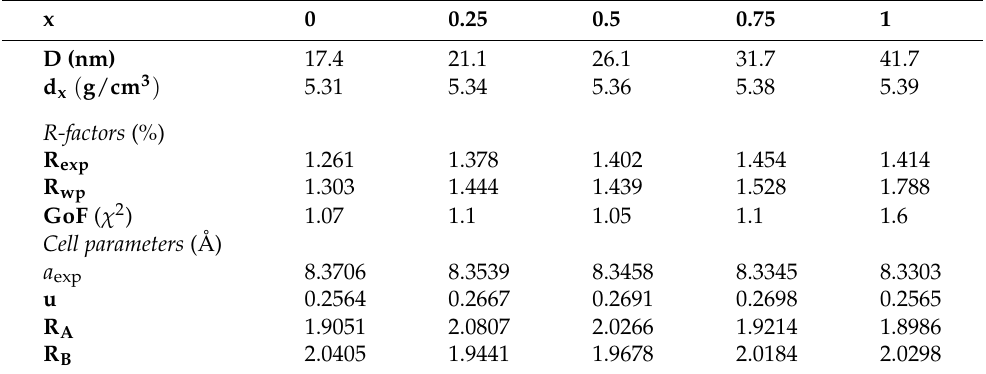
Table 2. Structural parameters and Rietveld agreement R-factors for the Ni x Co 1 − x Fe 2 O 4 ferrites with 0 ≤ x ≤ 1. The description of the parameters is given in the